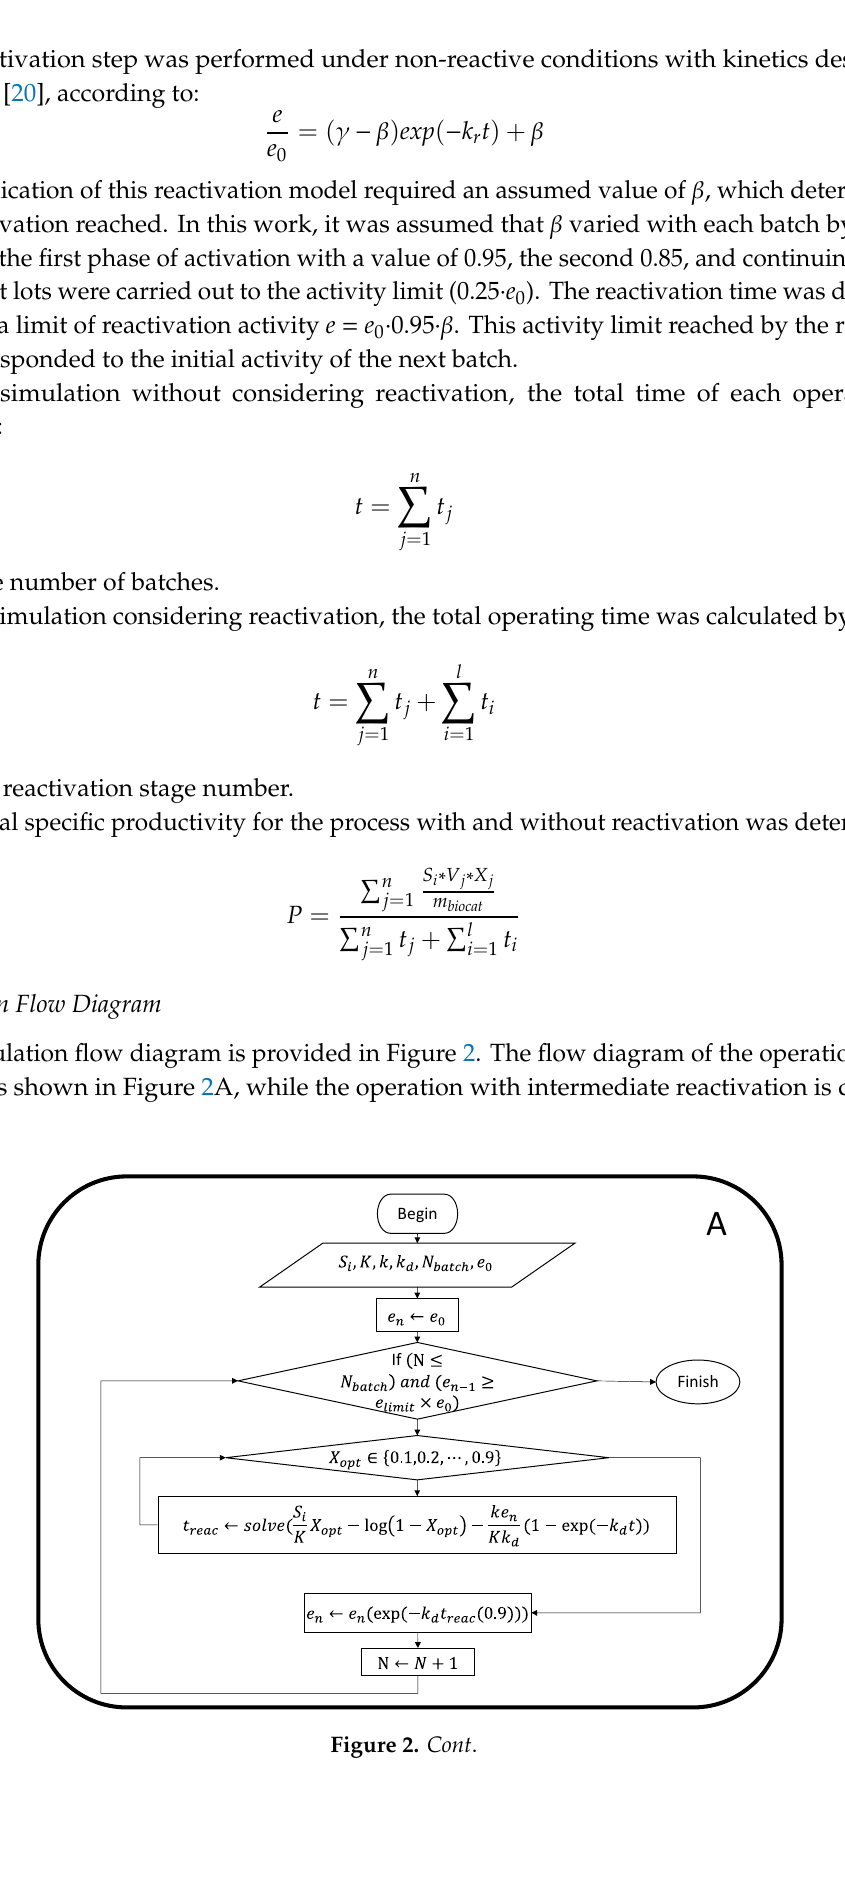
Figure 2. Simulation flow diagram: ( a ) without reactivation, ( b ) with reactivation. Details regarding the program code can be found in the repository [29]. 3. Results and Discussion 3.1. Simulation with and without Reactivation As an example, here we report results of the evaluation of processes with and without reactivation, obtained through simulations using data from work reported in the field [20,30,31]. These works were chosen because there are few investigations in which kinetic parameters have been determined in the enzymatic reactivation processes. The parameters and starting data are summarized in Table 1. Table 1. Data used to simulate system behavior. Parameter